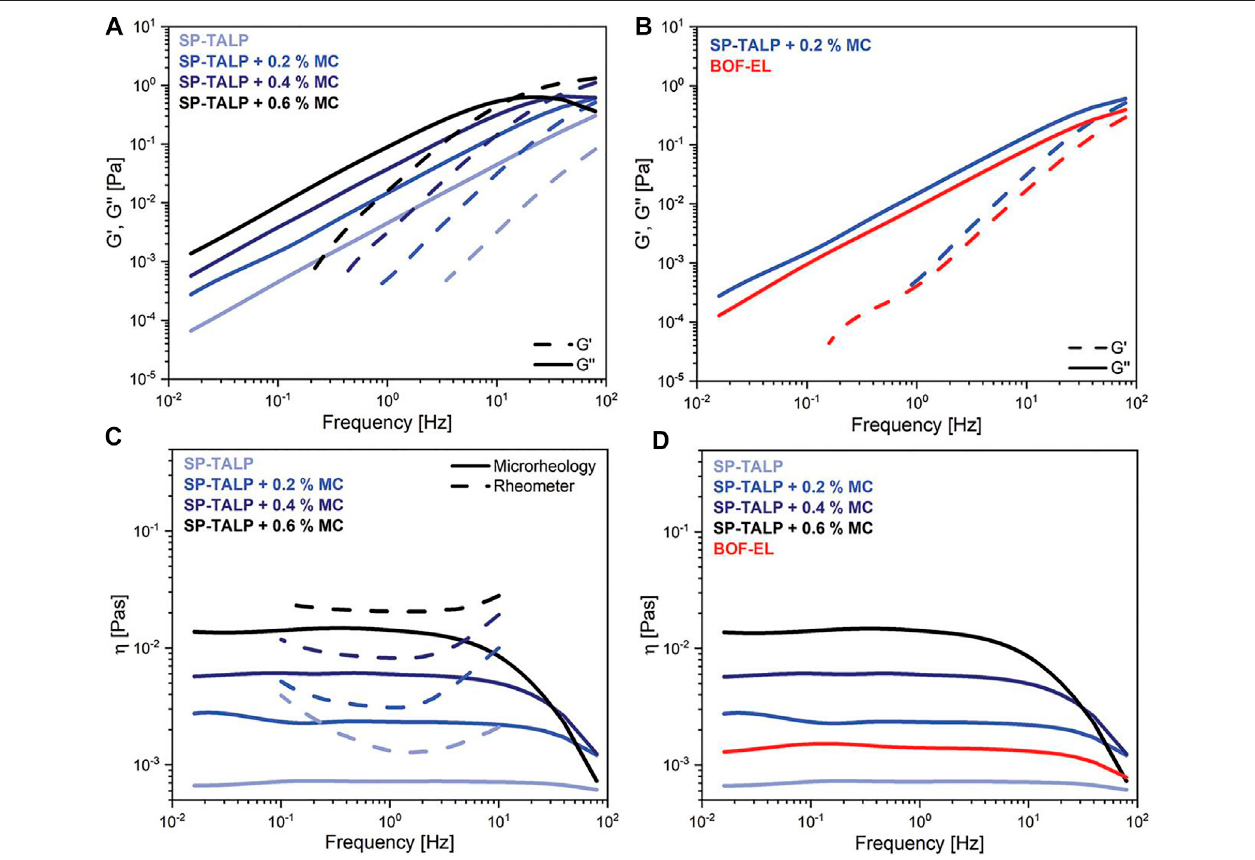
FIGURE 8 | Video particle tracking (VPT) microrheology and bulk rheology characterization of bovine oviduct fl uid (BOF) and viscoelastic methycellulose (MC)- enrichedanalogues. (A) StoragemodulusG ′ (dashedline)andlossmodulusG ″ (solidline)asafunctionoffrequencyofMC-enrichedSP-TALPmediaobtainedfromVPT at physiological temperature. (B) Storage and loss modulus of 0.2% MC and BOF-EL measured from VPT. (C) Microrheology measurements (solid line) overlaid by rotational rheometer measurements (dashed line) at physiological temperature. (D) Corresponding viscosities calculated from VPT data. Figure from Striggow, Friedrich, et al. “ Sperm-Driven Micromotors Moving in Oviduct Fluid and Viscoelastic Media. ” Small , vol. 16, no. 24, 2020, p. 2000213., doi:10.1002/smll.202000213. 00213., doi:10.1002/smll.202000213. Original work is available for use under the Creative Commons CC BY license.